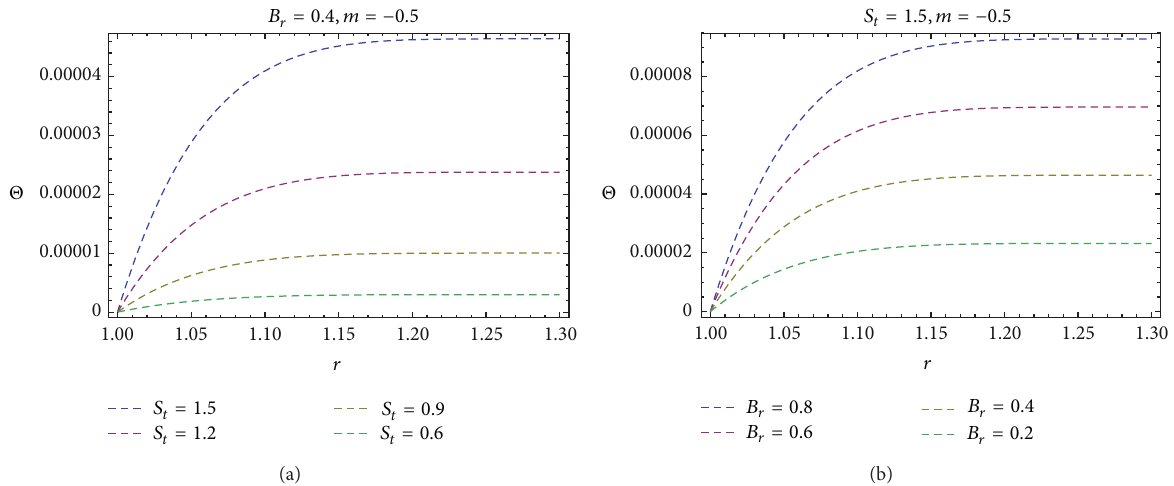
Figure 7: Effect on shear thinning fluid of 𝑆 𝑡 and 𝐵 𝑟 numbers on temperature for both